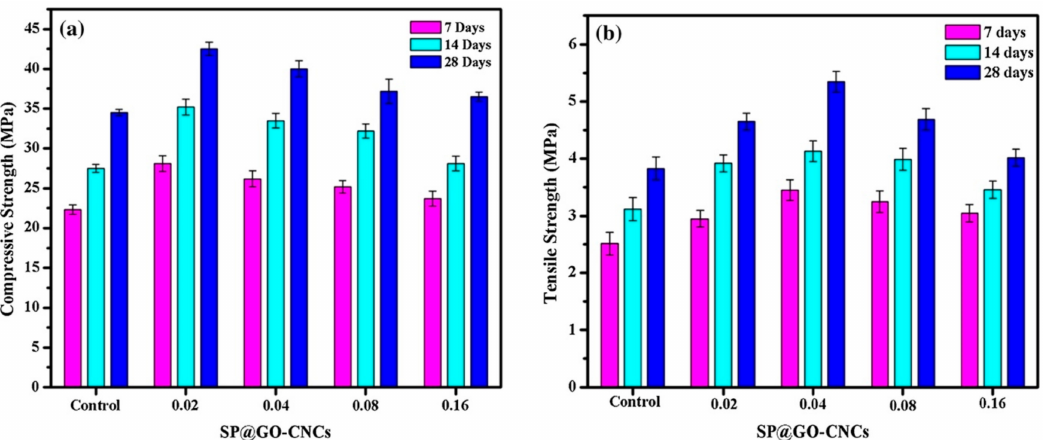
Figure 33. Experimental results of the ( a ) compressive and ( b ) flexural strength of SP@GO modified CNC specimens at curing ages of 7, 14 and 28 days. Reprinted with permission from [164]. Copyright © 2019, Elsevier